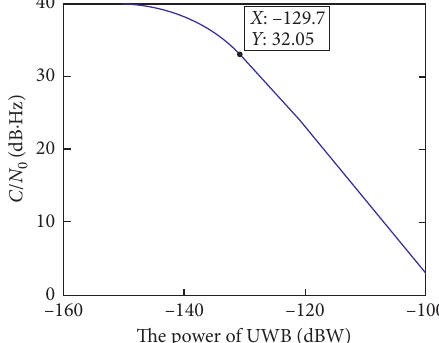
Figure 8: Receiver [ C / N 0 ] eq under UWB